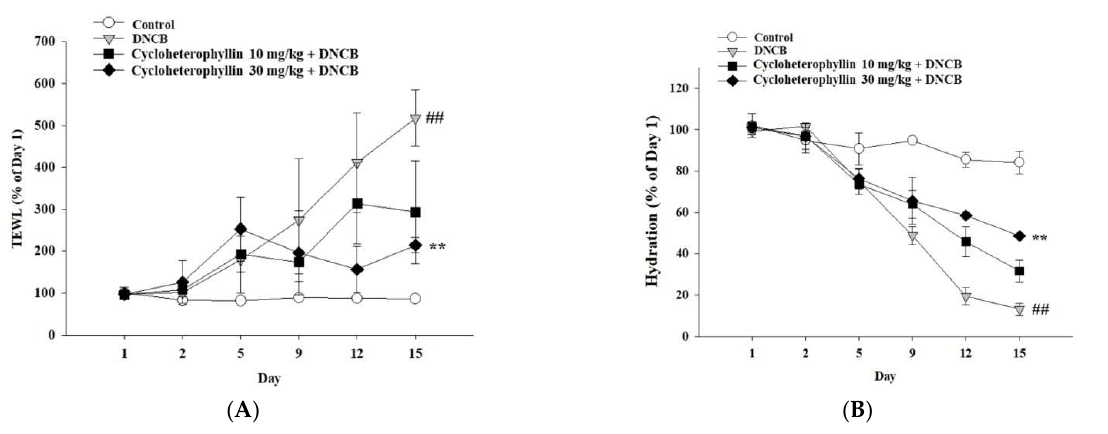
Figure 6. Changes in DNCB-induced skin physiological parameters of BALB/c mice after cycloheterophyllin pretreatment. Analysis of the effects of changes in transepidermal water loss ( A ) and hydration ( B ) in an atopic dermatitis-like phenotype in BALB/c mice. Values represent mean ± SEM from at least three independent experiments. ## p < 0.01 compared to untreated conditions; ** p < 0.01 compared to DNCB-induced group.